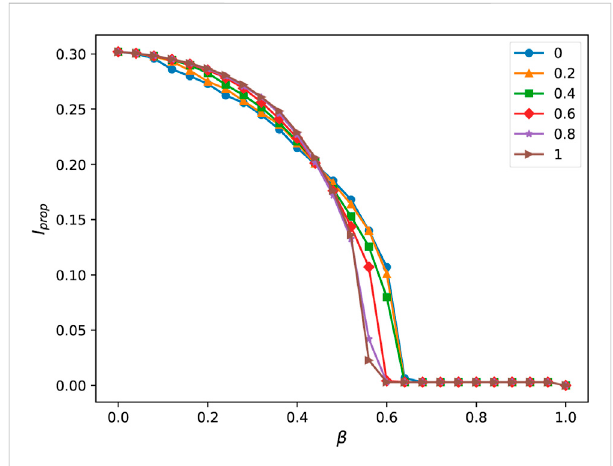
FIGURE 2 The effect of different values of η on epidemic suppression. We show the faction of infectious nodes in steady state ( I prop ), as a function of the fraction of removed edges ( β ) in usAir97 network ( μ = 0.06, γ = 0.4), where the numbers in the legend represent the values of η . Note that, the value of each point is the result of averaging 100 simulated values of I prop